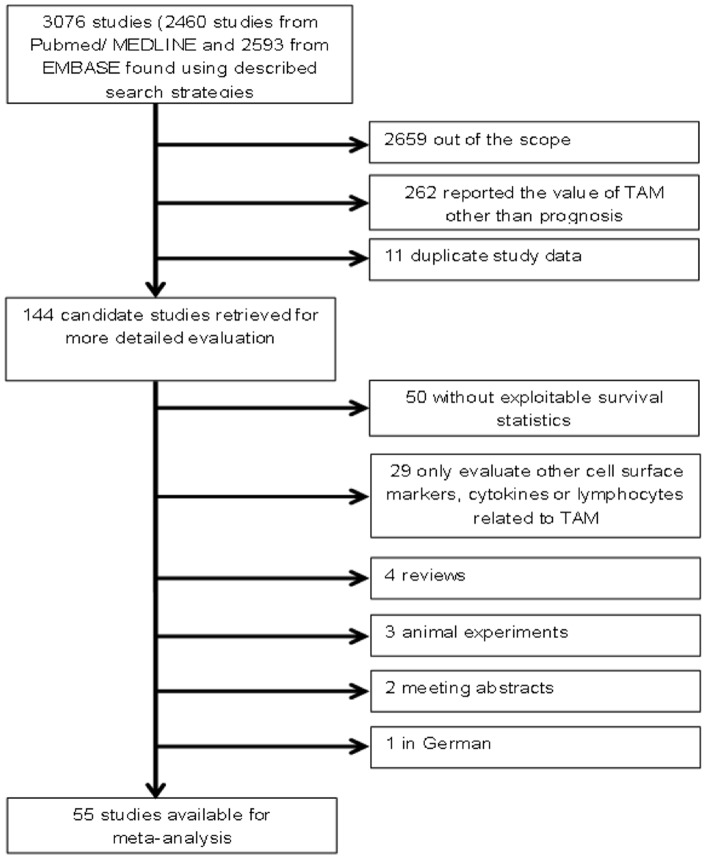
Flow chart of the literature search and selection of included studies.